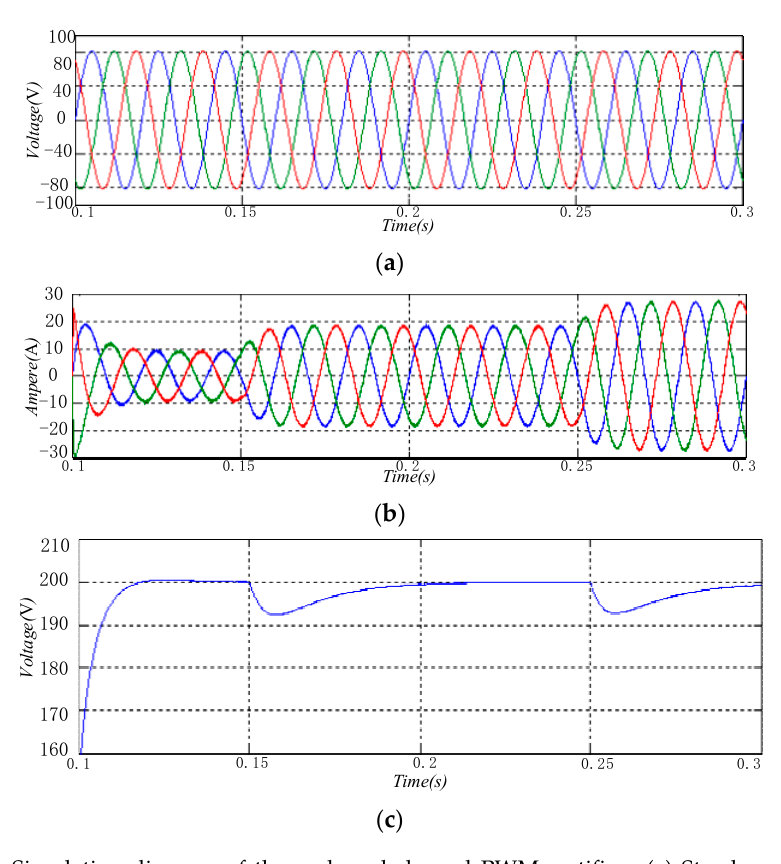
Figure 12. T he bode diagram of PWM rectifier DC side’s output impedance model.